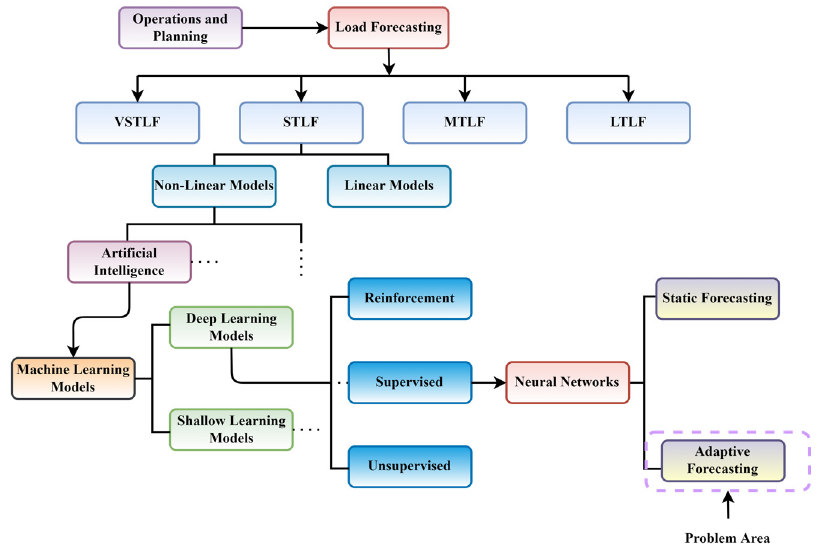
Figure 3. Hierarchical structure highlighting the existing problem areas of S.G. and D.G.M.